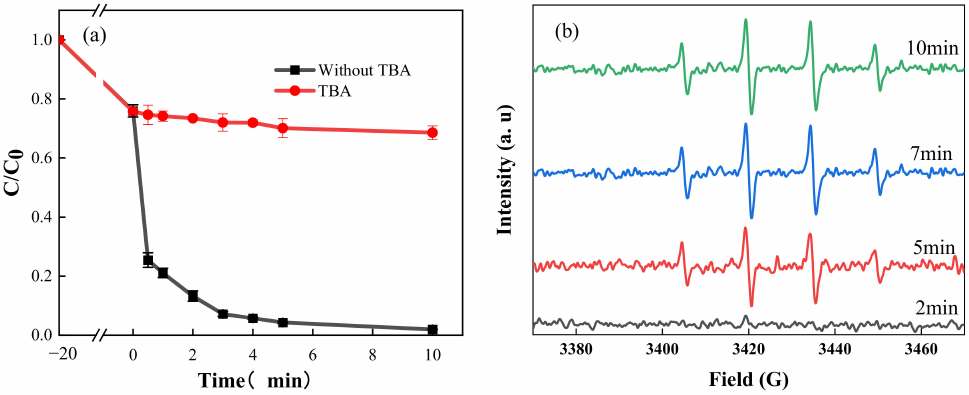
Figure 8. ( a ) Effect of TBA on MB degradation; ( b ) EPR spectra of DMPO– •